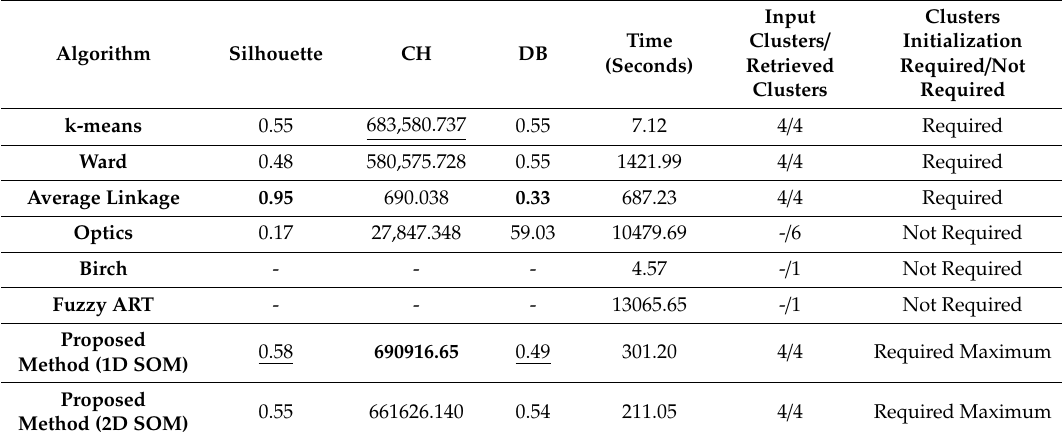
Table 1. The comparison of the proposed technique with state-of-the-art clustering algorithms over DOE buildings performance dataset.